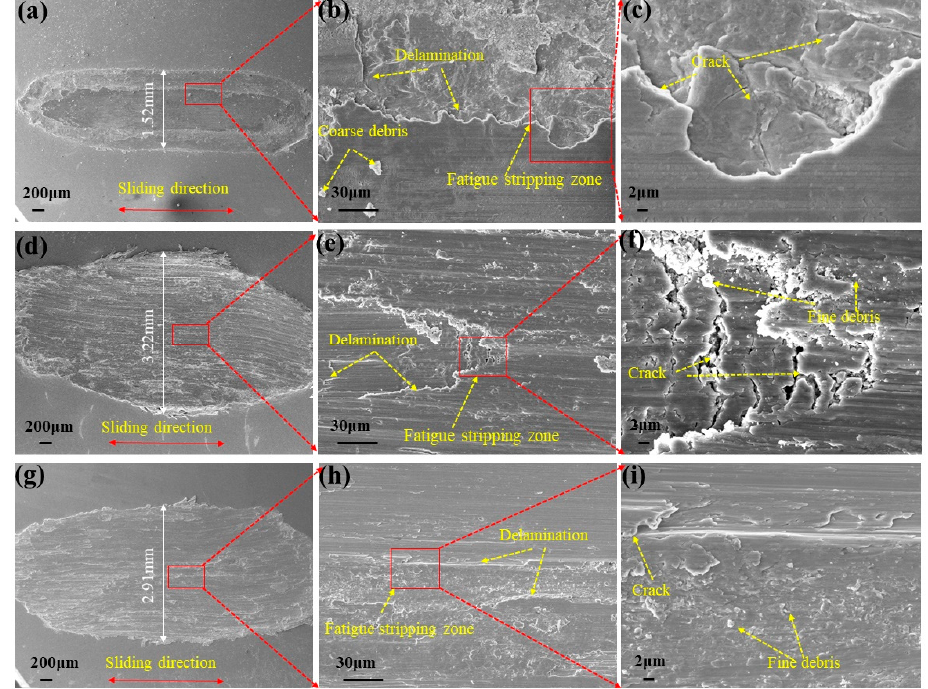
Figure 14. Scanning electron microscope images show the wear patterns of the longitudinal wear marks of AISI 316L specimens ( a – c ), Ti2 specimens ( d – f ), and Zr1 specimens ( g – i ) under dry friction conditions.